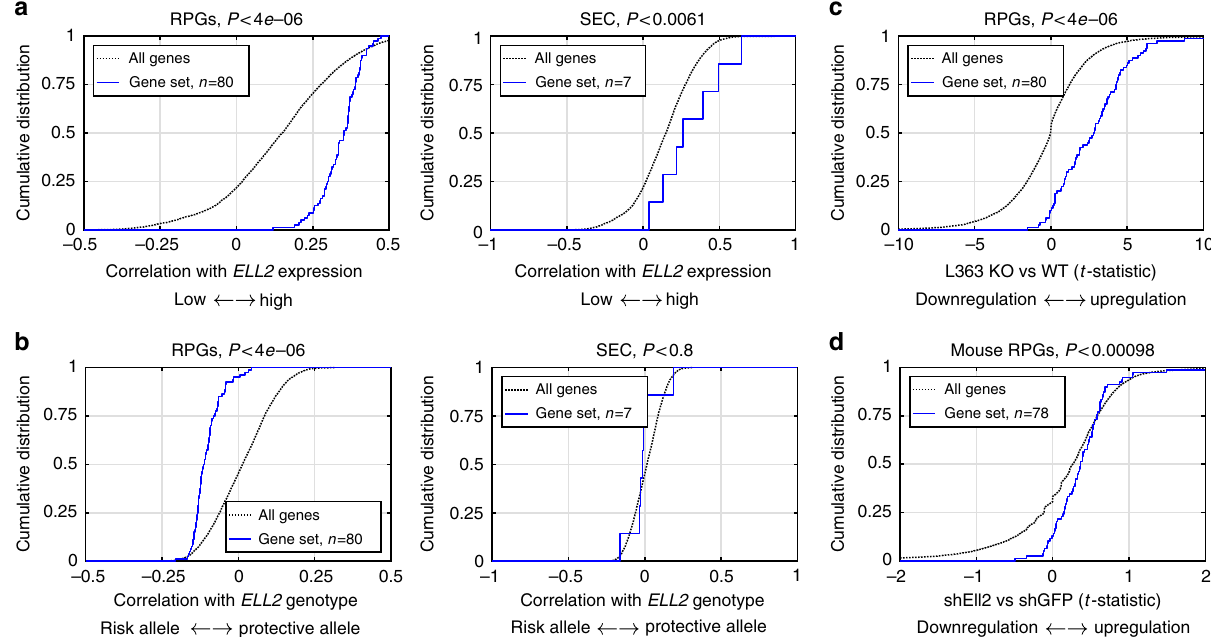
Fig. 4 The ELL2 MM risk allele increases ribosomal gene expression. a To explore the downstream effects of reduced ELL2 function, we fi rst calculated the correlation between ELL2 and other genes in the Swedish-Norwegian mRNA-sequencing data. Here, ELL2 showed signi fi cant correlation with a large set of genes. Enrichment analysis revealed an over-representation of positive correlations among multiple gene sets related to ribosomes biogenesis and function, including ribosomal protein coding genes (RPGs) and the SEC (see also Supplementary Table 6). b Enrichment analysis of correlation between the ELL2 MM risk allele and gene expression in the same dataset identi fi ed RPGs and other gene sets related to ribosomes. This enrichment was in the direction of the ELL2 risk allele, which confers lower ELL2 expression (see also Supplementary Table 7). c Similarly, analysis of ELL2 CRISPR-Cas9 knockout (KO) L363 cells showed an upregulation of RPGs and other gene sets related to ribosome biogenesis and function (see also Supplementary Tables 8 and 9), i.e., effects in the same direction as the ELL2 MM risk allele. d Finally, similar changes were seen in mouse MPC1 plasmocytoma cells treated with shRNA against either Ell2 vs GFP. These data support that, in addition to the effect on ELL2 itself, the ELL2 MM risk allele confers additional changes in gene expression, including an increased expression of genes involved in ribosomal biogenesis, possibly as a compensatory